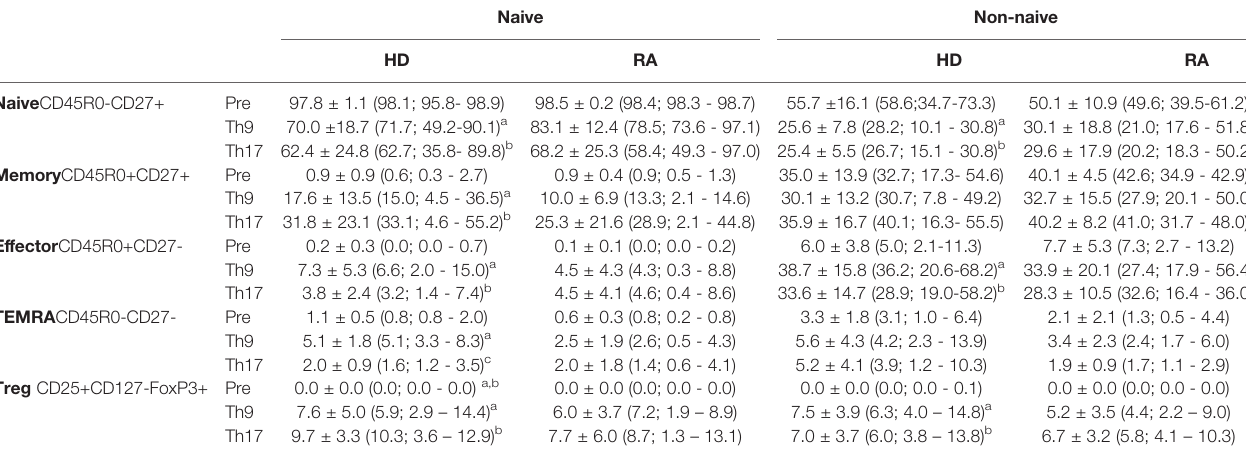
TABLE 2 | Proportions of differentiated T cell subpopulations in native (Pre) and Th9- or Th17-stimulated naive and non-naive CD4+ T cells.